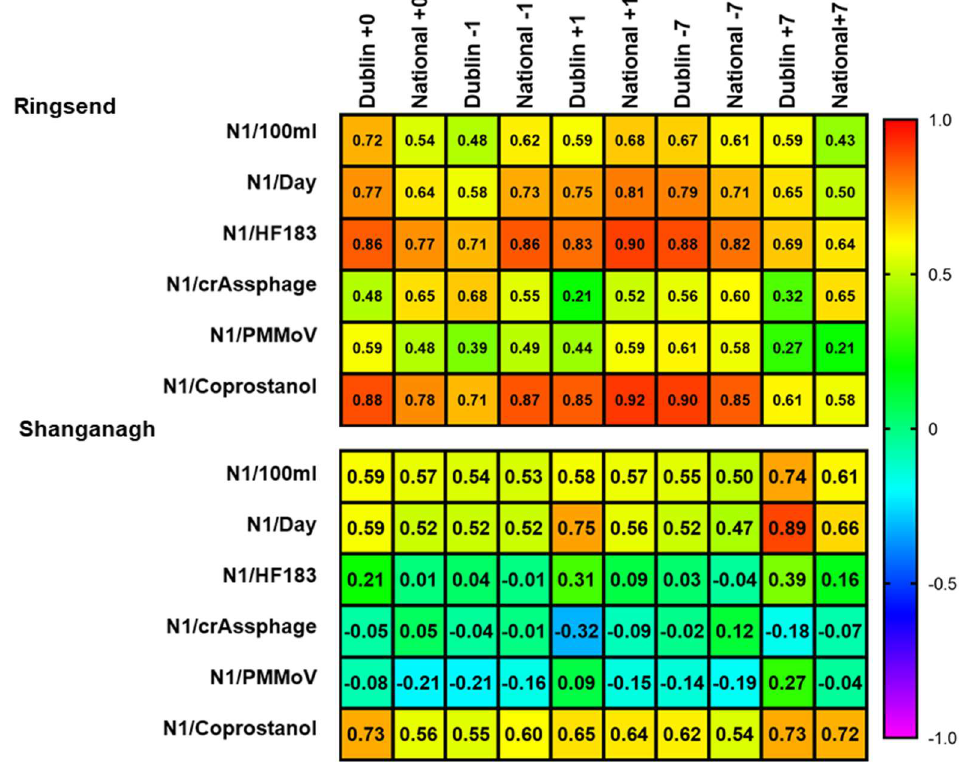
Figure 2. Heatmap showing correlations between normalised and non-normalised SARS-CoV-2 levels in Ringsend and Shanganagh and national and Dublin COVID-19 cases. R 2 coefficients > 0.65 were considered as indicating strong correlations with a statistically significant cut-off of p < 0.05.